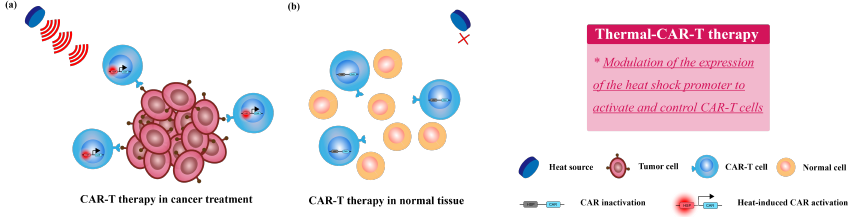
Figure 4. The mechanism of synergetic thermal therapy and CAR-T therapy. ( a ) T cells with inducible CAR cassettes containing heat-shock promoters are activated when heated locally and thus eradicate the tumor cells. ( b ) In normal tissue, without being heated, the T-cells with inducible CAR cassette remain inactivated and thus reducing the on-target off-tumor toxicity of standard CAR-T